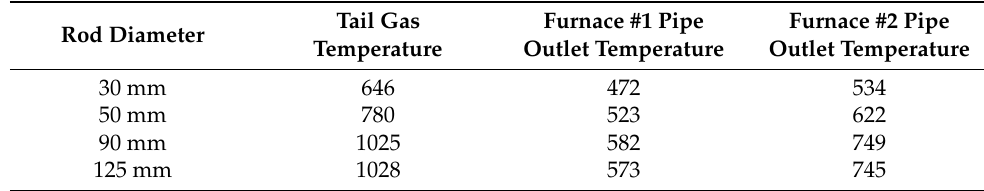
Table 5. Temperature of tail gas